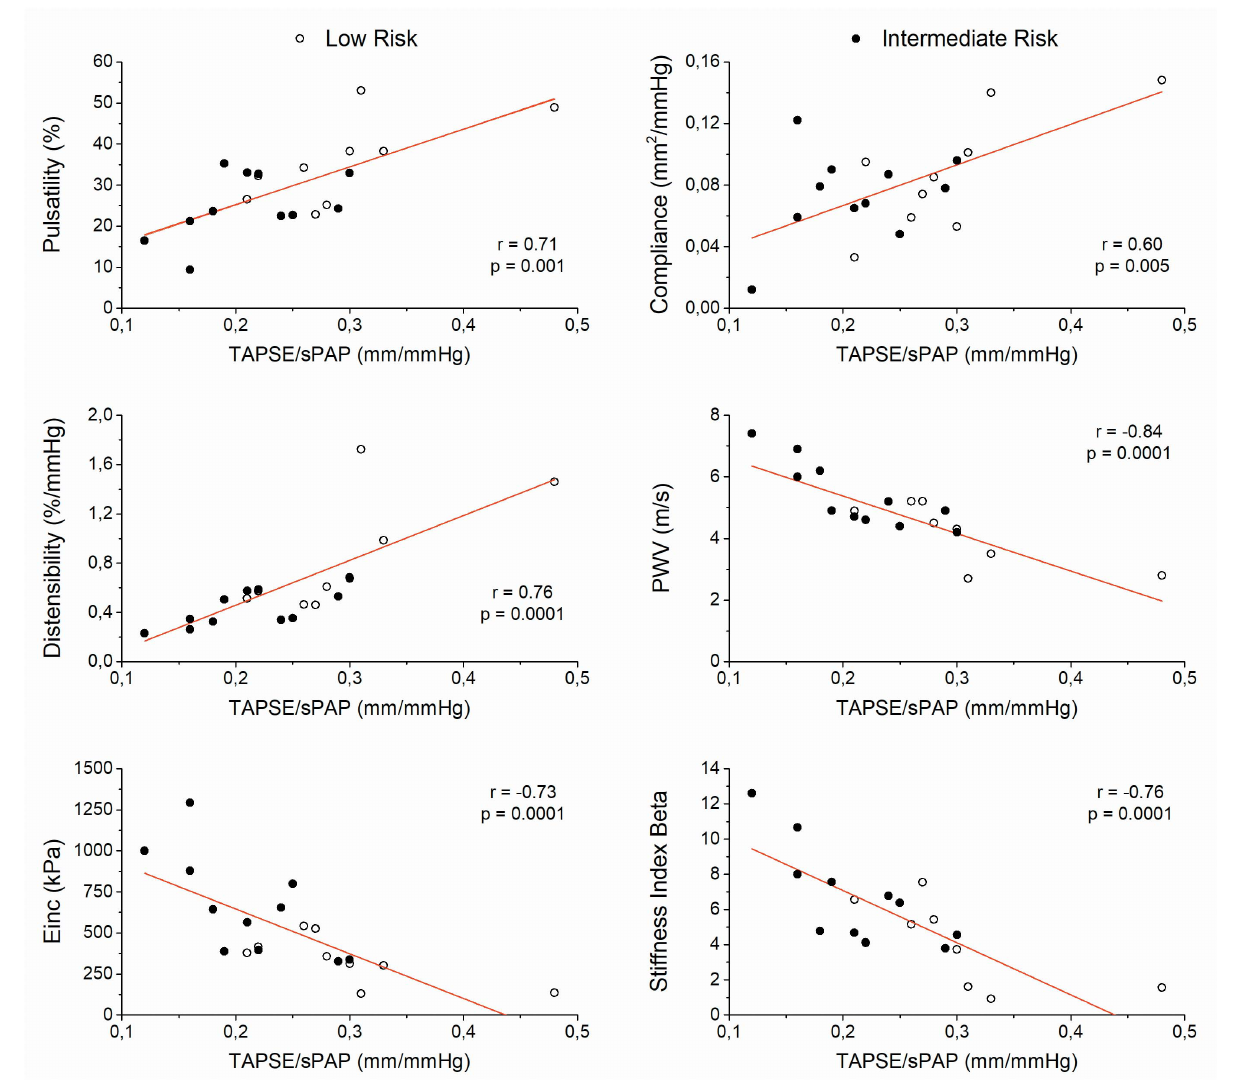
FIGURE 4 | Scatter plots between pulmonary arterial stiffness indices and the ratio of tricuspid annular plane systolic excursion to systolic pulmonary artery pressure (TAPSE/sPAP) (Einc, incremental elastic modulus; PWV, local pulse wave velocity). ( n = 9 low-risk patients; n = 11 intermediate-risk patients).